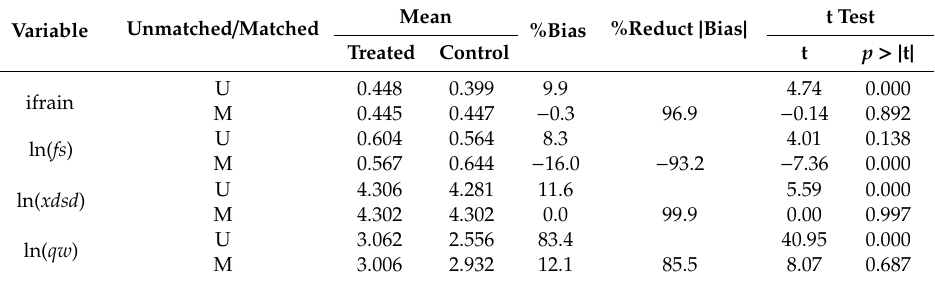
Table 4. The PSM validity test 1: